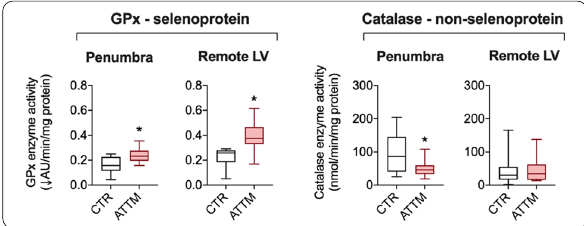
Figure: Glutathione peroxidase (GPx) and catalase enzyme activity. AU, arbitrary units; LV, left ventricle. Data: median, IQR and range. *p < 0.05 vs control (CTR); unpaired T-test (Prism 9). Sample size: control, n ATTM-treated, n =